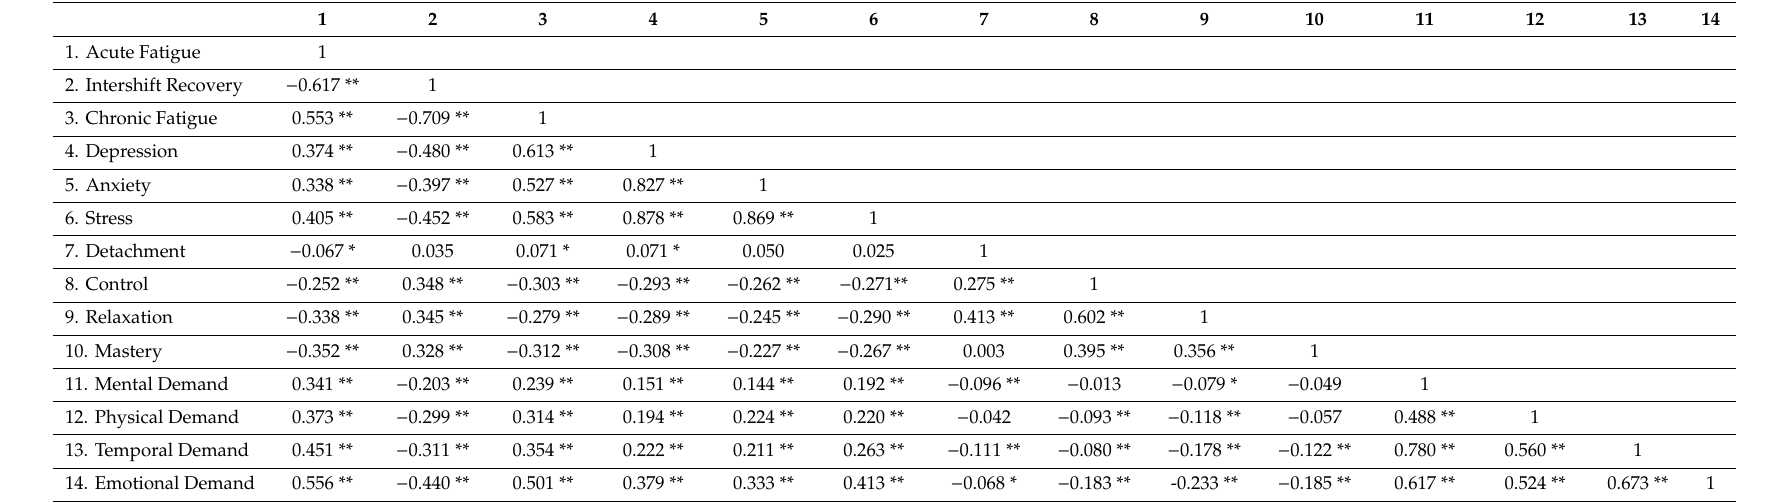
Table 5. Intercorrelation among mental health parameters, work demands, and recovery